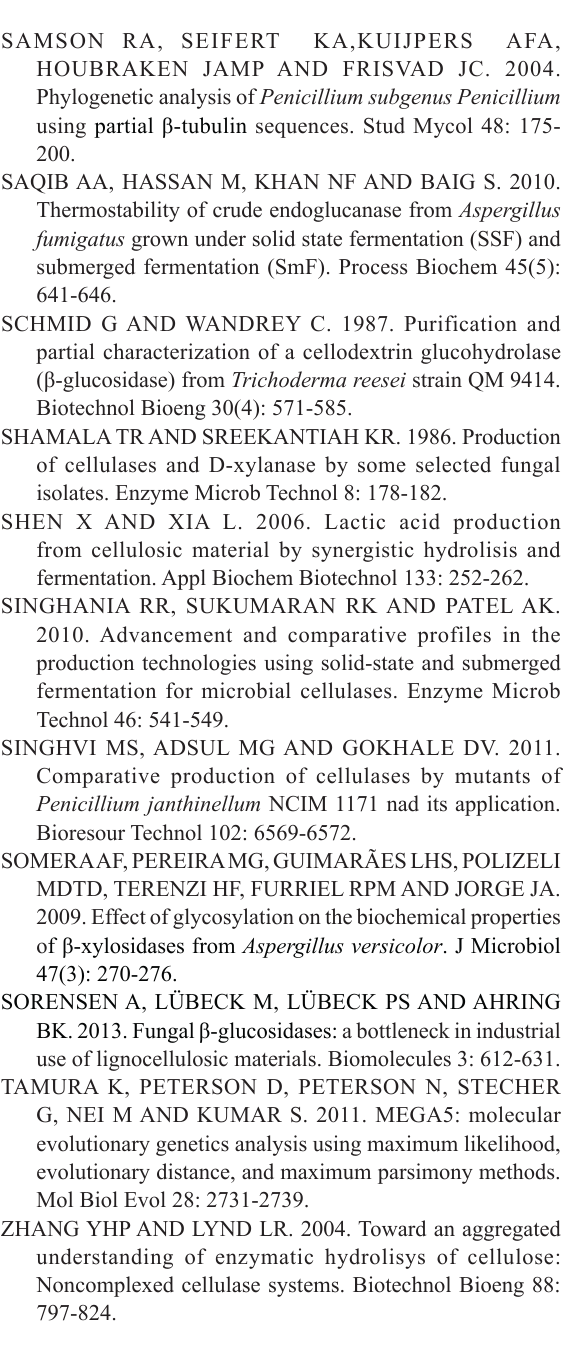
Figure S1 - The neighbor-joining tree obtained based on phylogenetic analysis of β-tubulin sequence data. Talaromyces convolutus was chosen as out-group . Numbers above branches are bootstrap values and in parentheses are the accession numbers in genBank. Only values above 50% are indicated. T = ex